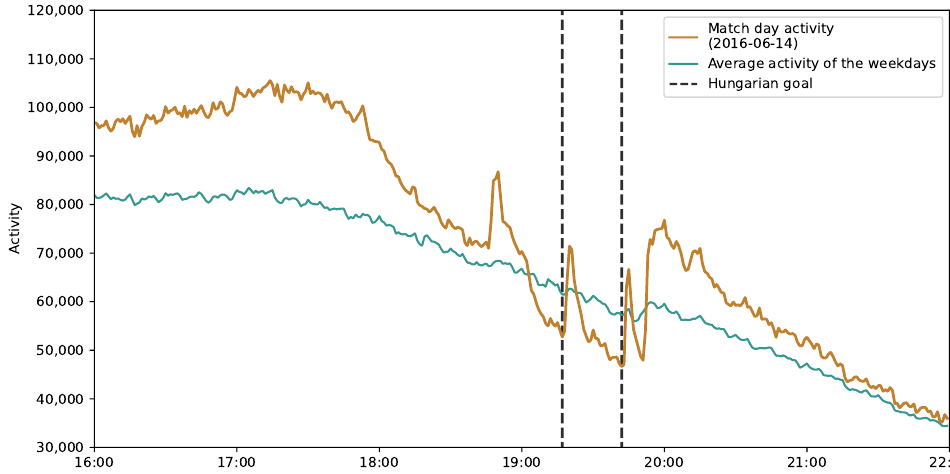
Figure 9. Mobile phone activity during and after the Austria–Hungary Euro 2016 match in compari- son with the average activity on